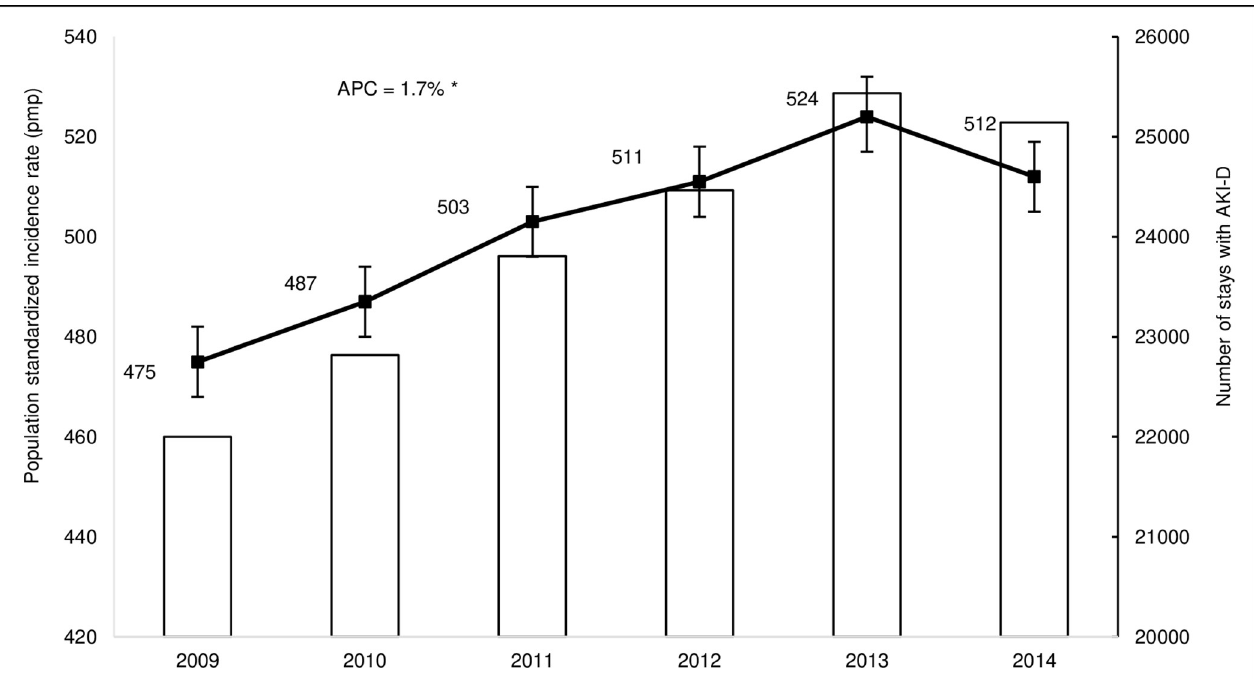
Fig 2. Population incidence of acute kidney injury requiring dialysis in metropolitan France from 2009 to 2014 (absolute number of stays and standardized incidence rate per million population). For 2009, the absolute number of stays and the crude incidence rate were reported as an estimation over 12 months based on observations for 9 months. I bars represent 95% CIs for standardized incidence rates. � indicates that the Annual Percent Change (APC) is significantly different from zero at the alpha = 0.05 level.